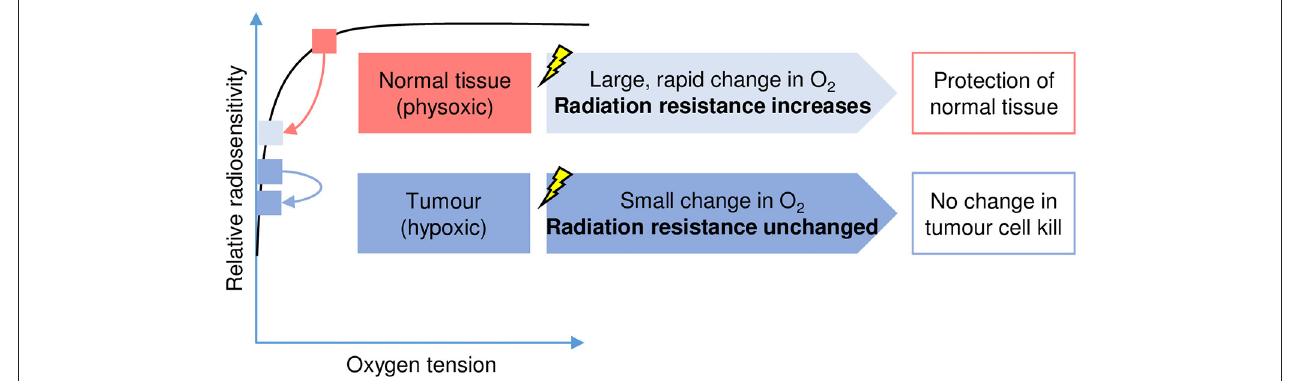
FIGURE 2 | The oxygen depletion hypothesis. The relationship between oxygen tension (horizontal axis) and radiation sensitivity (vertical axis) is shown schematically and has been widely reported (40, 41). In response to FLASH-RT, the physiological level of oxygen (physoxic) found in normal tissues decreases rapidly (pink arrow) and has an important impact on radiation sensitivity. This temporary or transient hypoxia protects the normal tissues as radiation resistance increases. In contrast, oxygen levels are low (hypoxic) in tumor tissues and consequently FLASH-RT has less of an impact on radiation